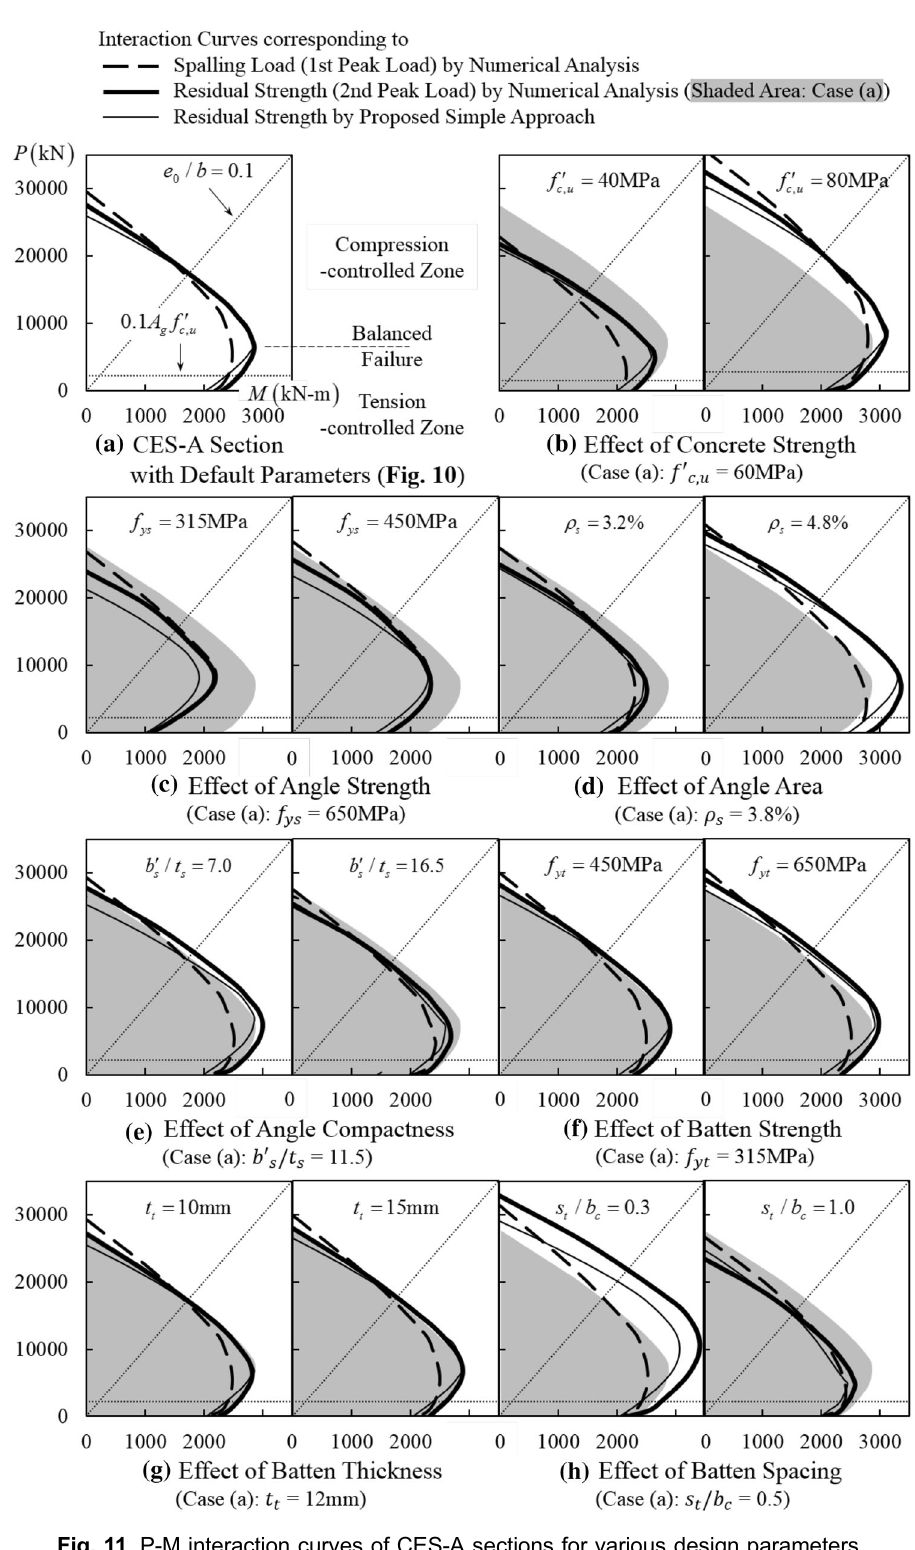
Fig. 11 P-M interaction curves of CES-A sections for various design